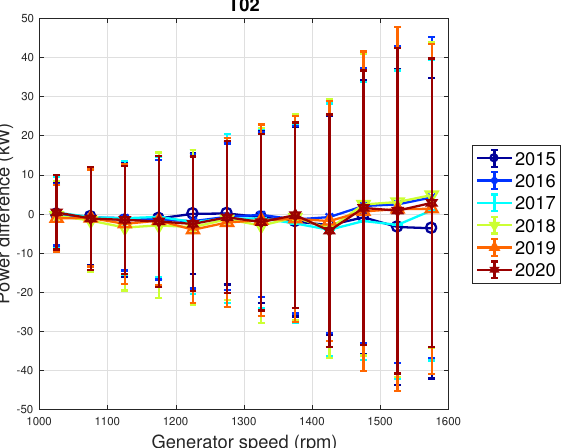
Figure 11. Binned generator speed–power curve in Region 2 for T02 in WF2: the curves are reported in the form of difference with respect to the year 2014.